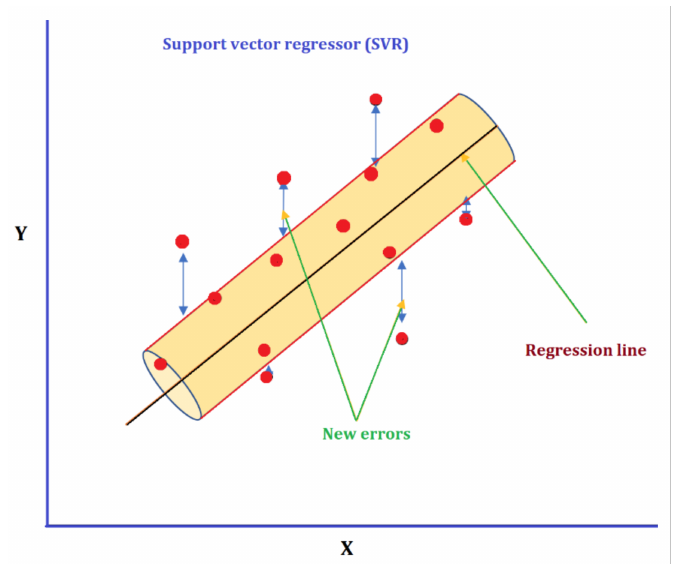
Figure 2. Concept of SVR